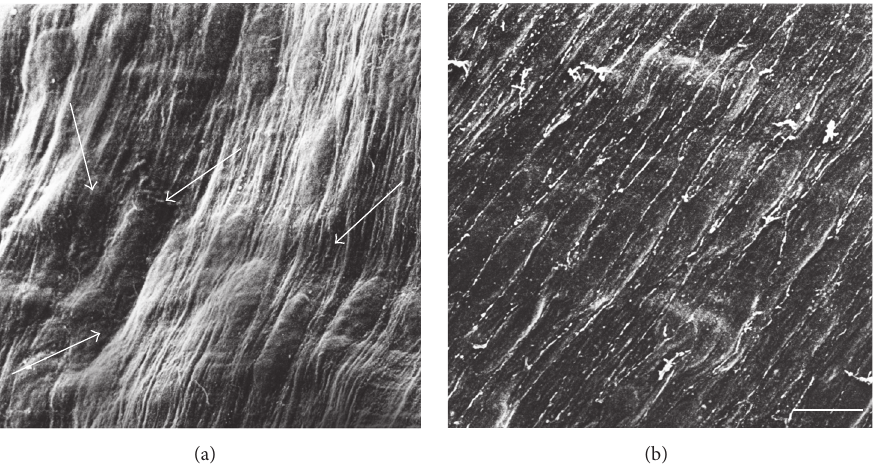
Figure 2: Scanning electron micrographs of venous endothelial cells without (a) or with (b) microwave irradiation. Guinea pig venous blood vessels were fixed conventionally with 1/2 Karnovsky’s solution (a). Shrinkage of the smooth muscle cell layer occurred (a: arrows). After fixation with microwave irradiation, the flattened endothelial cell layer located in the inner surface of blood vessels was well-preserved (b). Arrows in (a) indicate the wavy artifacts caused by shrinkage of the smooth muscle cell layer. Compare (a) without microwave irradiation and (b) with microwave irradiation; the microwave irradiation showed good preservation of the endothelial cell layer morphology (b). Bar = 10 𝜇 m. See also